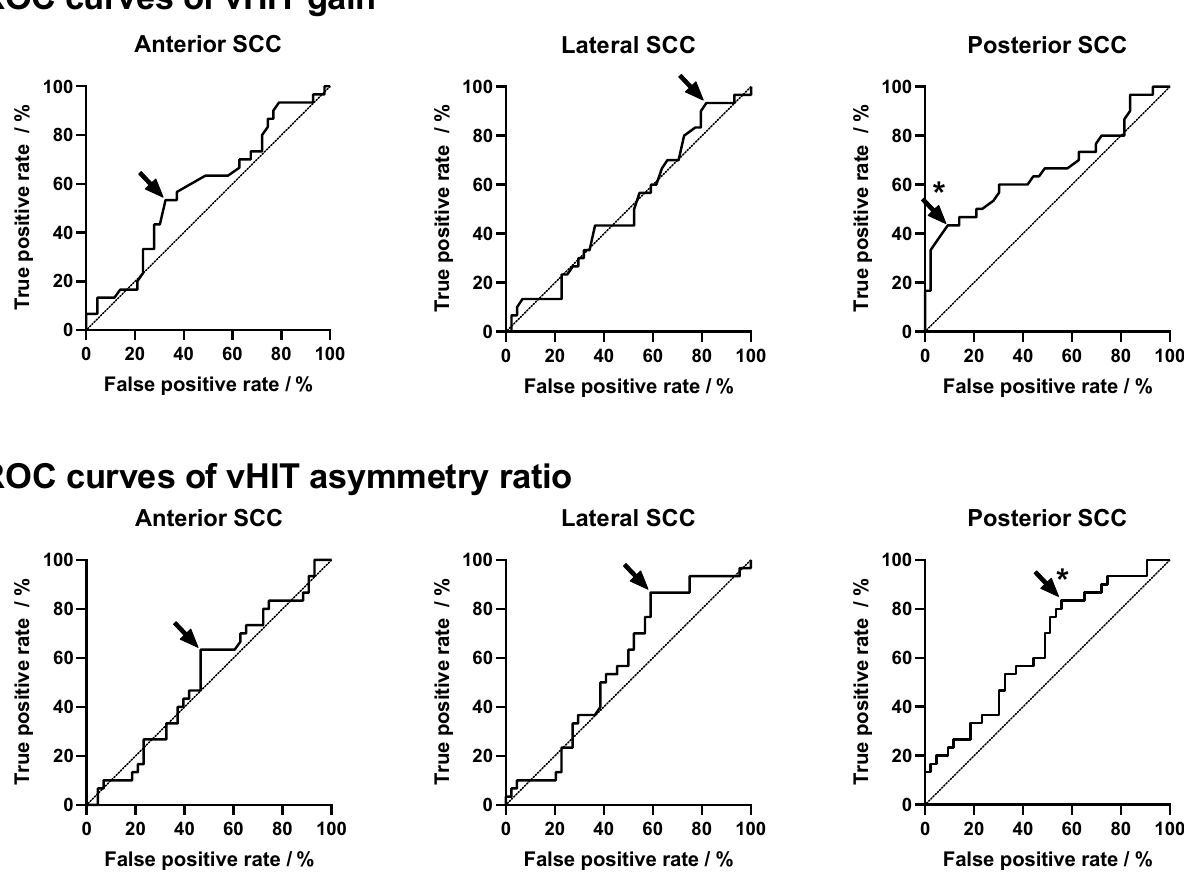
Figure 3. ROC curves for nerve of origin analysis based on vHIT gain and asymmetry ratio measures. The diagonal marks random classification. Asterisks (*) mark significant areas under curve (p < 0.05). Arrows mark the optimized cut-off